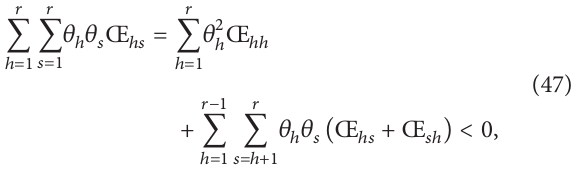
Algorithm 12. Find the communication and filter